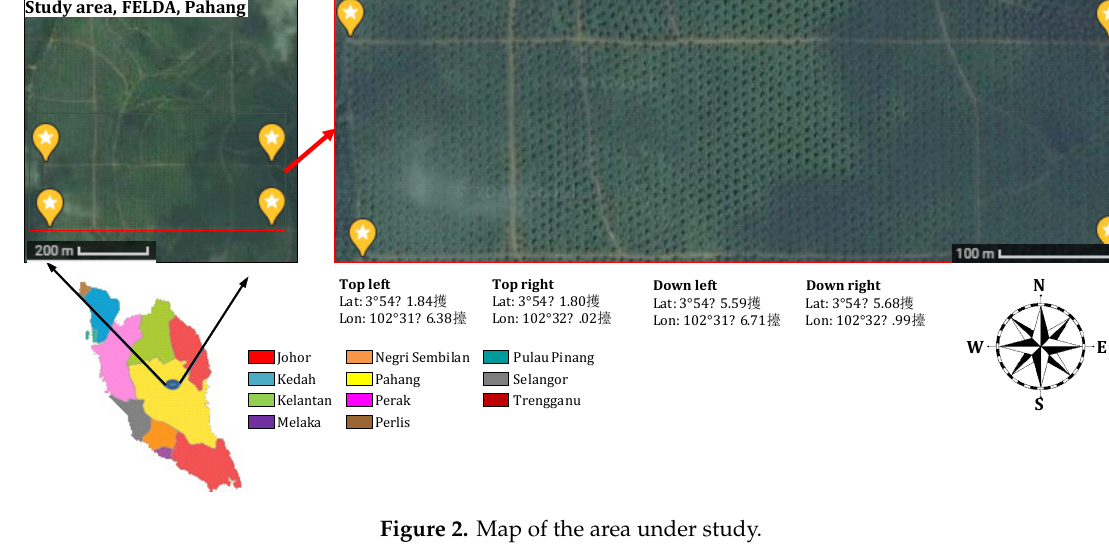
Figure 2. Map of the area under study.